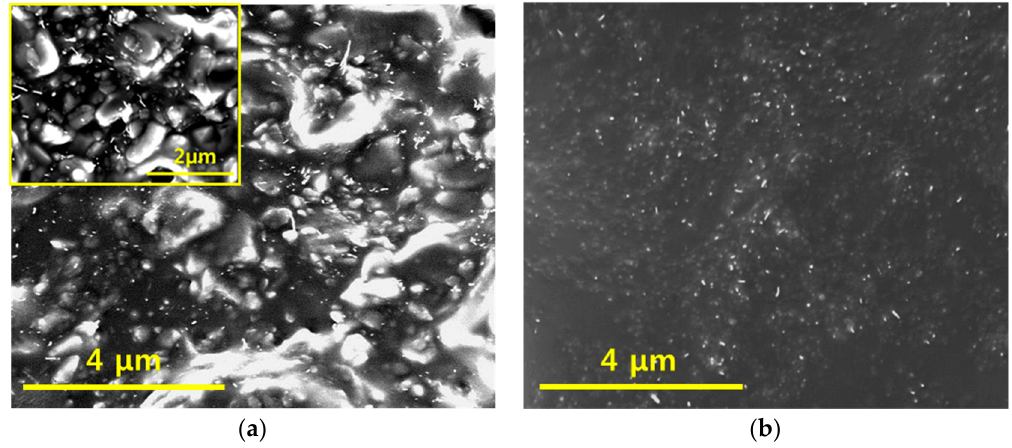
Figure 4. SEM images of ( a ) CNT/micro-silica/PDMS composite and ( b ) CNT/PDMS composite (both 6 wt% CNT). The inset shows a high resolution image of CNT/micro-silica/PDMS composite.